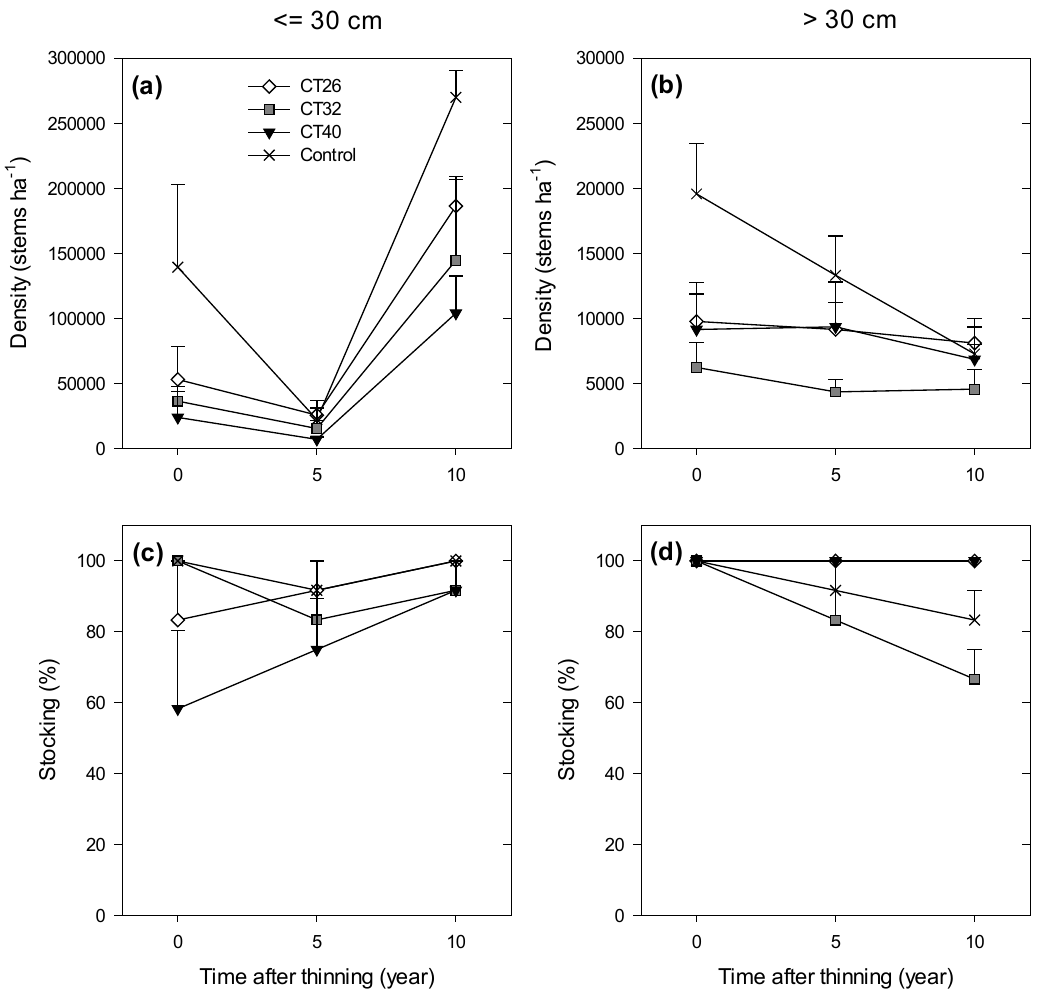
Figure 6. Decennial development of ( a , b ) regeneration density and ( c , d ) stocking by height class (≤30 cm; >30 cm) after four commercial thinning intensities from below (0%, 26%, 32% and 40% merchantable basal area